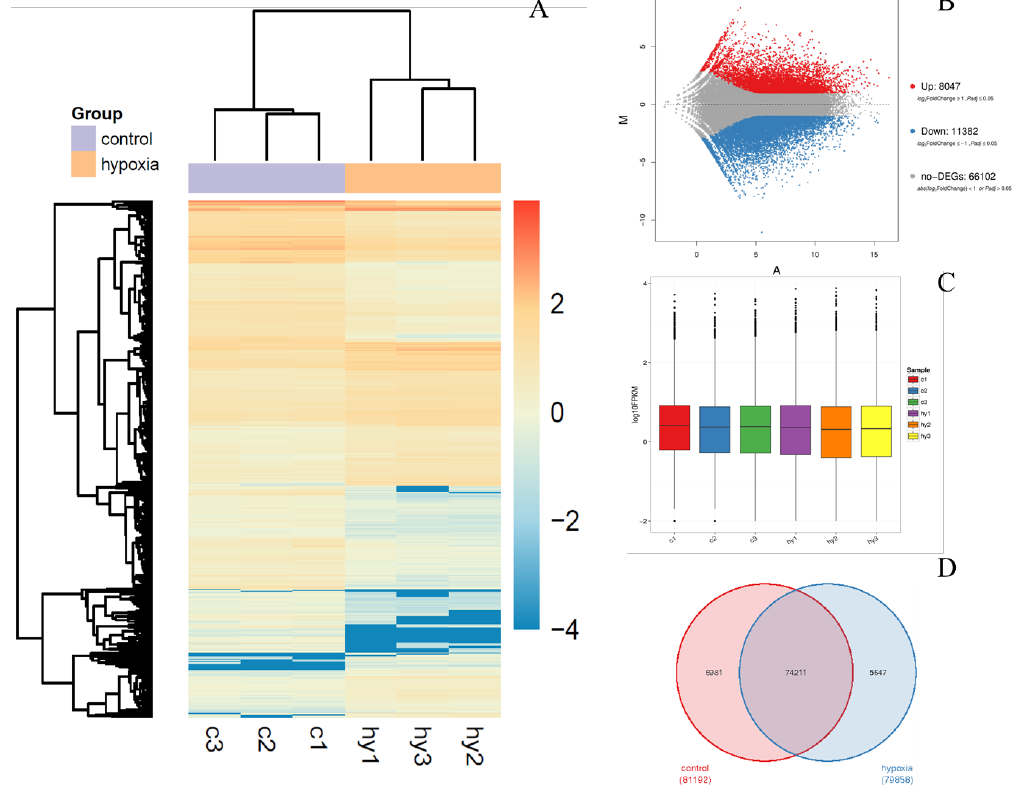
Figure 5. Expression analysis of the differentially expressed genes (DEGs) in distal root tissues of three samples of aerated control plants (c1, c2, c3) and in three samples from plants subjected to three days of root hypoxia (hy1, hy2, hy3). ( A ) Hierarchical cluster analysis with different columns in the figure representing different samples, and different rows representing different genes. The colors from blue to yellow indicate gene expression from low to high respectively. ( B ) Bland–Altman (MA) plot. Each point in the MA plot represents a gene. The blue points represent downregulated genes, the red points represent upregulated genes, and the grey points represent unchanged genes. ( C ) Fragments per kilobase of transcript per million mapped reads (FPKM) boxplot. ( D ) Venn diagram representing the specific and common DEGs across the control vs. hypoxia.